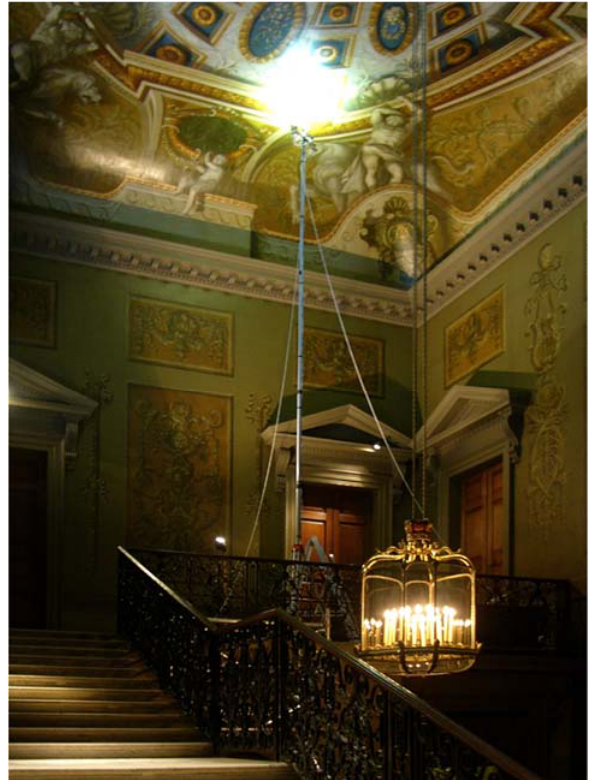
Figure 14. Mast fully raised to 8m above the gallery with the photographic rig operating 60cm below the